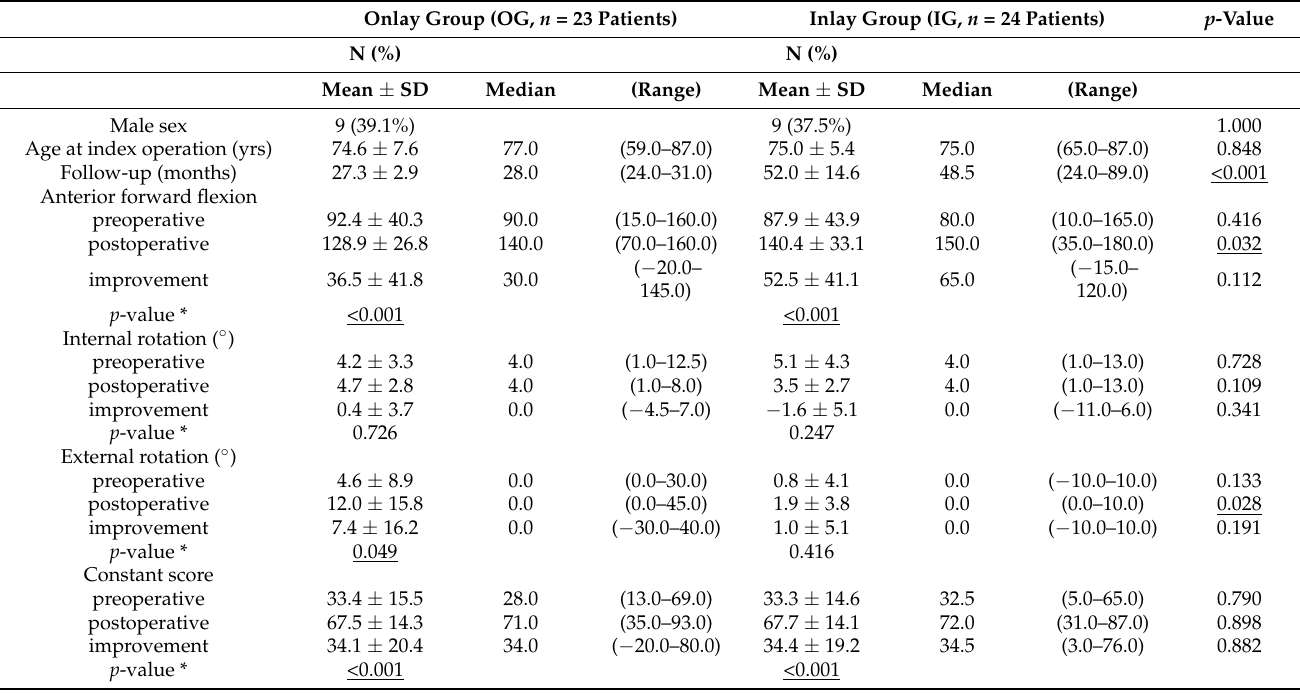
Table 2. Comparison Analysis of Pre- and Postoperative Data between Onlay and Inlay Groups. Onlay Group (OG, n = 23